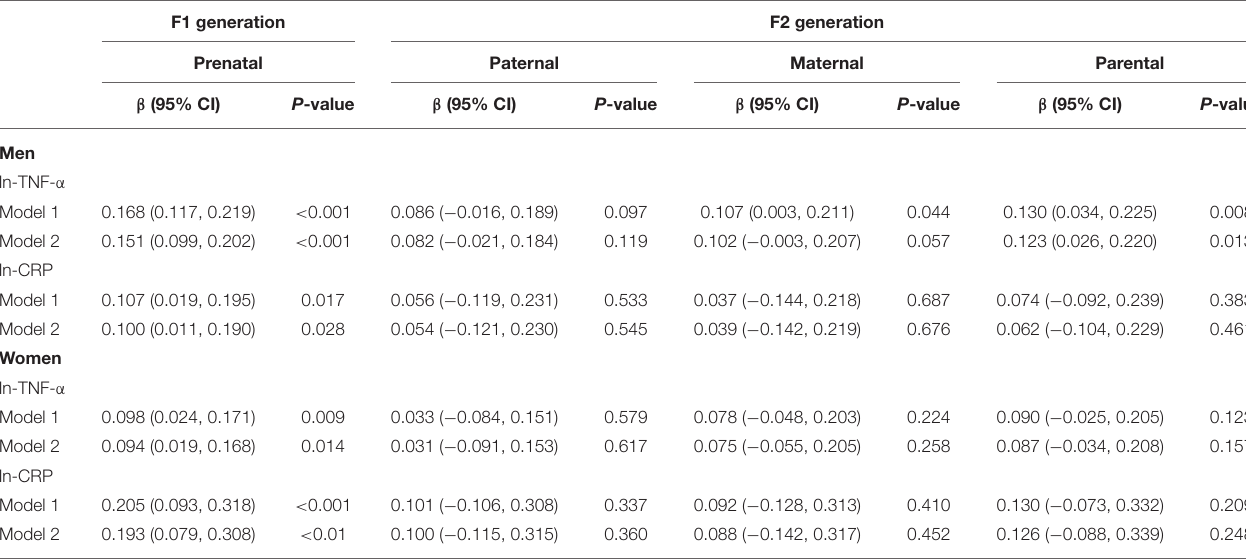
TABLE 2 | Association of famine exposure with the inflammatory markers in both generations. F1 generation F2 generation Prenatal Paternal Maternal Parental